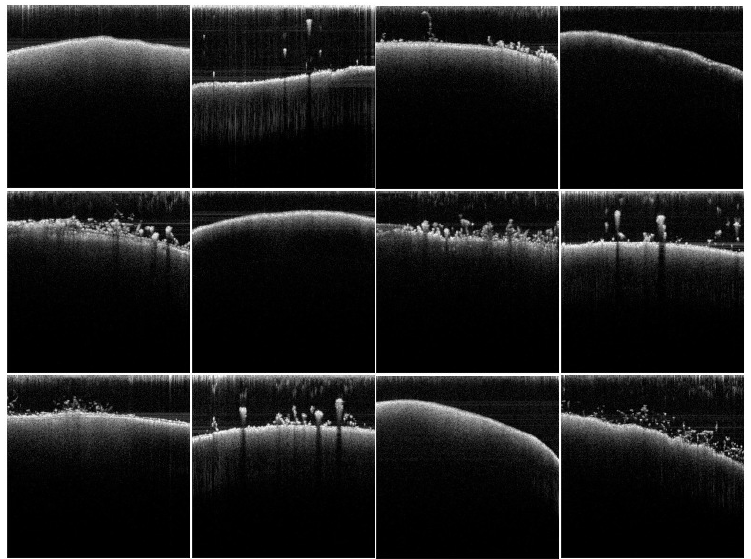
Figure 4. Exemplar un-segmented OCT images used as input for the preprocessing step before feature extraction ECOC-SVM model training.